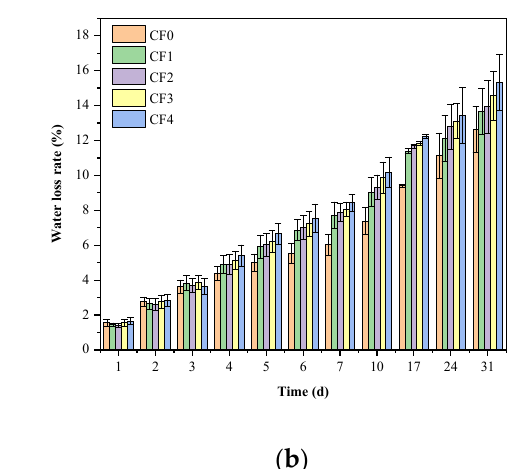
Specimens Figure 6. Total drying shrinkage coefficient of CSM with 100% RMA under different fly ash replacement rates.